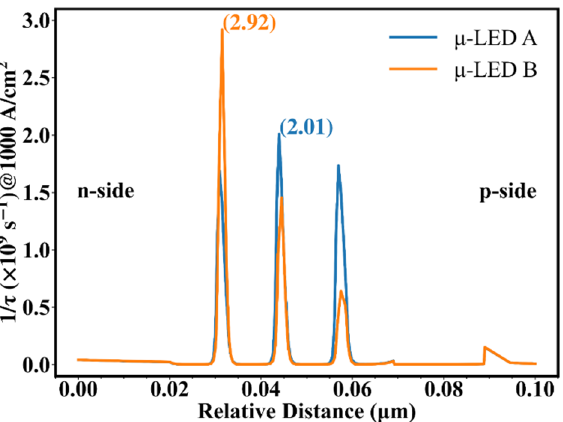
Figure 5. Reciprocal carrier lifetime vs. relative distance at 1 kA/cm 2 for µ -LED A and µ -LED B. To further illustrate the advantages of µ -LED B, we modify the QW thickness of µ - LED A to 2.5 nm, denoted as µ -LED C (Figure S1). At 1 kA/cm 2 , we calculated the carrier distribution and carrier wave function of µ -LED C (Figure S2 and Figure S3), then compared the peak electron concentration, peak hole concentration, the peak of 1/ τ (Figure S4), and the marked in brackets, and the QWs from the n-side to the p-side are sequentially denoted